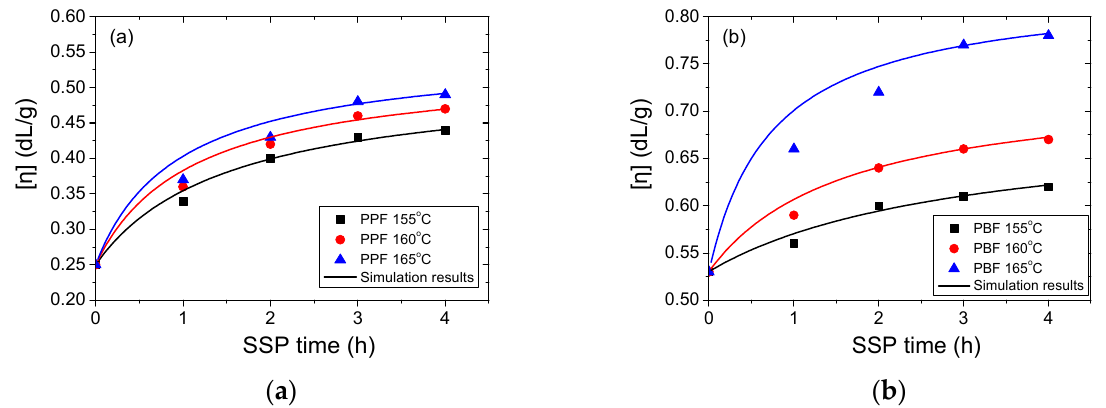
Figure 3. Evolution of the intrinsic viscosity (IV) with time during SSP of ( a ) PPF and ( b ) PBF polyesters at di ff erent temperatures. Simulation results are represented by the continuous lines.